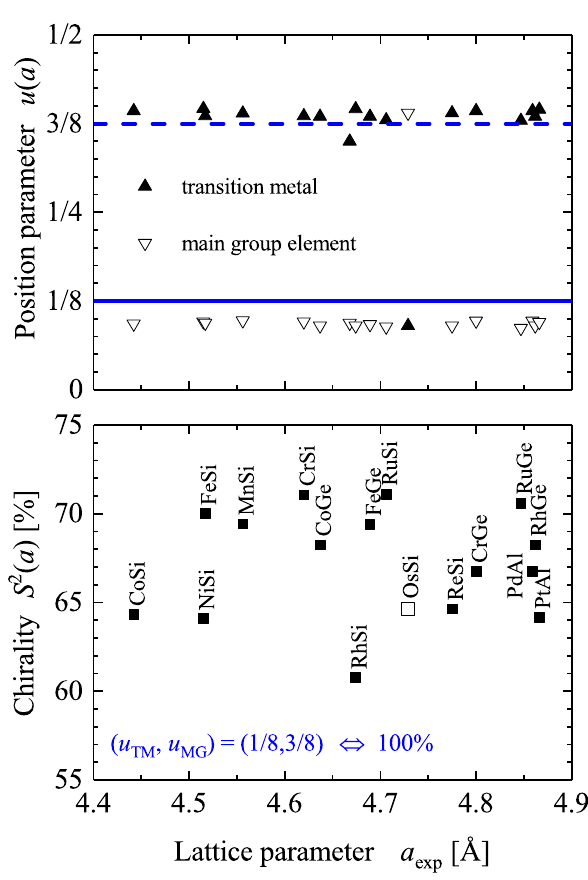
Figure 8. Chirality of the B 20 compounds. Continuous chirality measures of B 20 compounds where the complete structure determination is reported in Pearson’s database [20]. The full and dashed lines mark u values of 1/8 and 7/8,